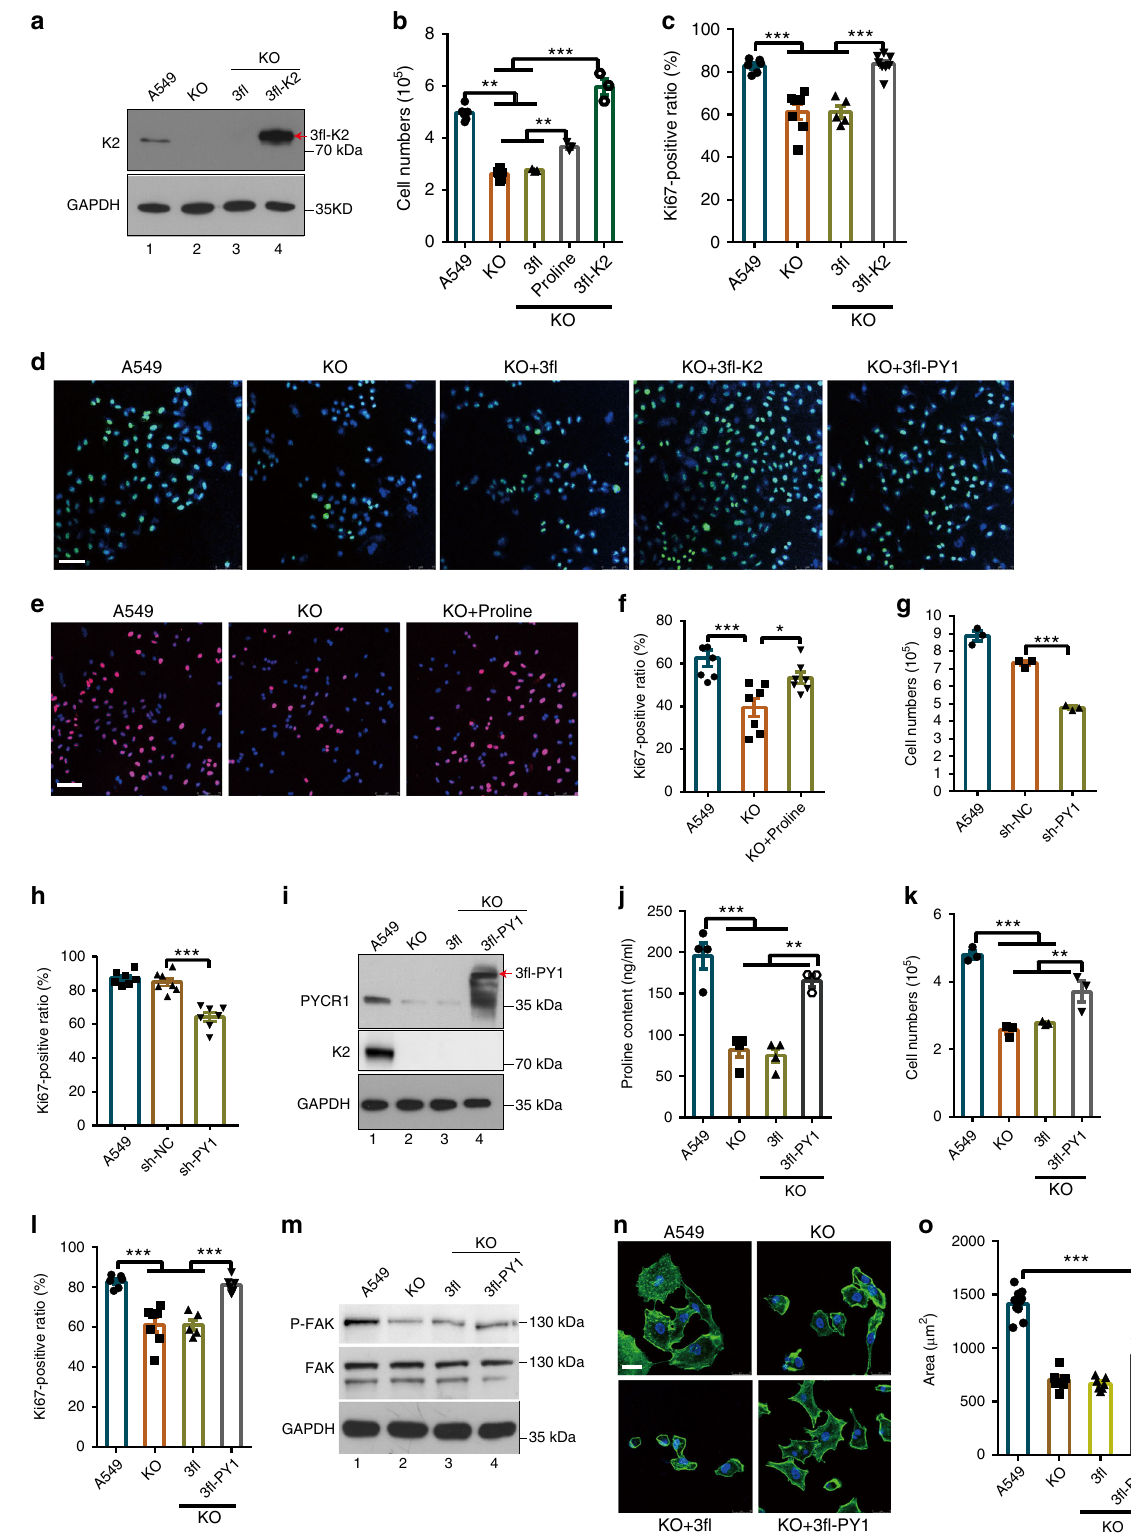
PYCR1 and proline levels and cell proliferation, beg the question as to whether kindlin-2 is involved in promoting lung